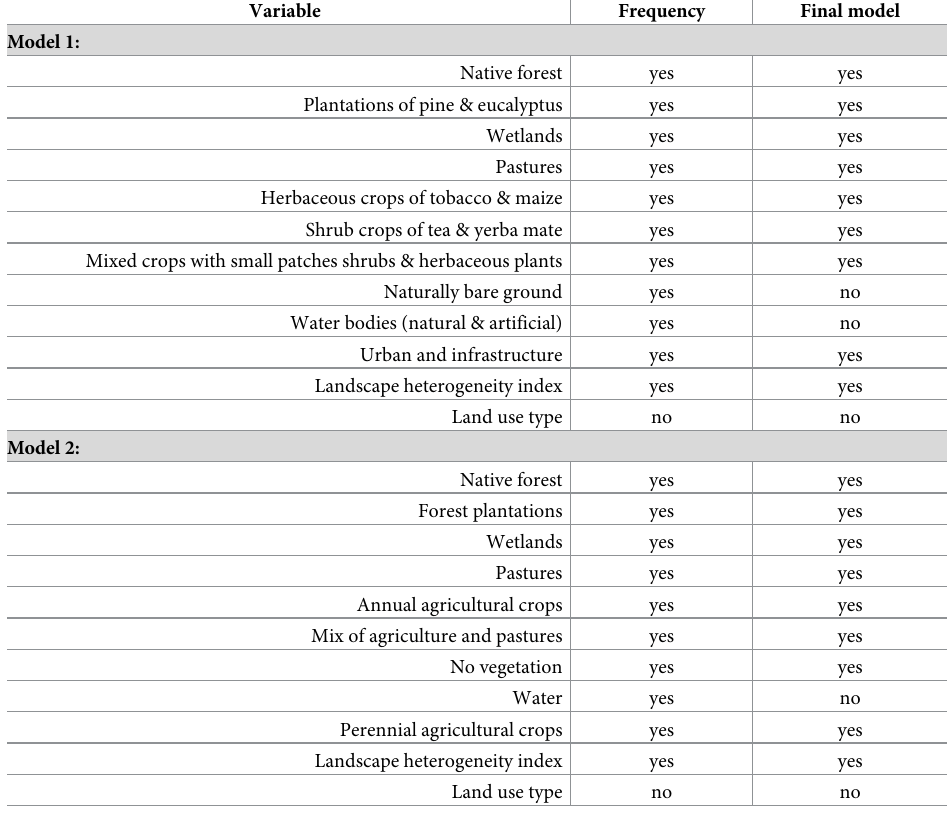
Table 1. Summary of predictor variables tested and used in the two species-specific ecological niche models gener- ated in this work. Variable Frequency Final model Model 1: